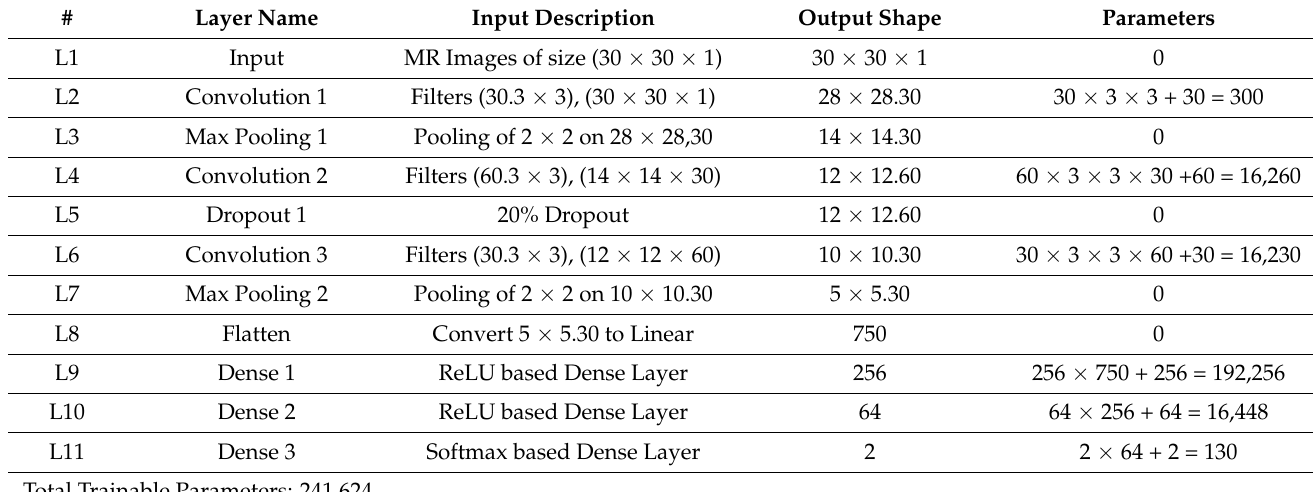
Table 6. Proposed CNN model 3 specifically for Glioma tumor